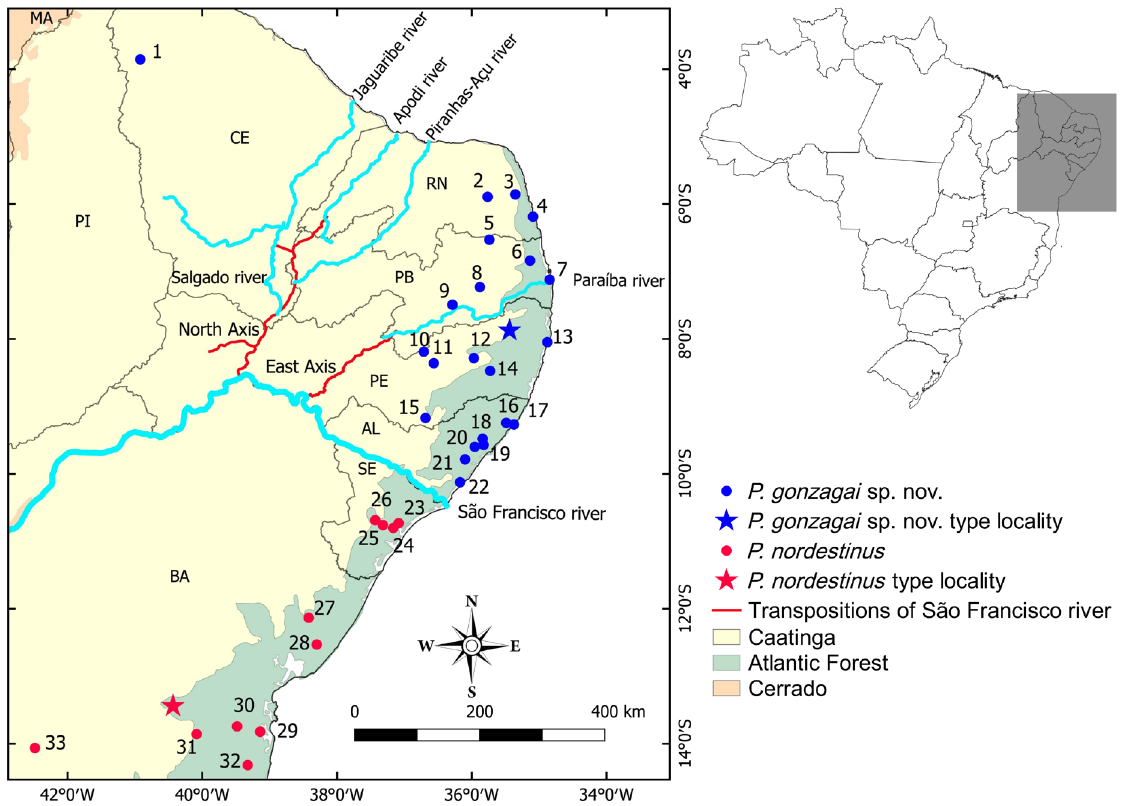
Fig. 1. Map showing molecular, morphological and acoustic samples used in the comparisons between Pithecopus gonzagai sp. nov. (red dots and star) and P. nordestinus (Caramaschi, 2006) (blue dots and star) in north-eastern Brazil. We indicate the original São Francisco River path (blue) and the new path after the installation of the North and East Axes (in red) as a result of the Transposition Project. Municipalities: 1 = Ubajara (CE); 2 = São Paulo do Potengi (RN); 3 = Macaíba (RN); 4 = Tibau do Sul (RN); 5 = Araruna (PB); 6 = Mamanguape (PB); 7 = João Pessoa (PB); 8 = Campina Grande (PB); 9 = Cabaceiras (PB); 10 = Poção (PE); 11 = Sanharó (PE); 12 = Caruaru (PE); 13 = Recife (PE); 14 = Bonito (PE); 15 = Bom Conselho (PE); 16 = Passos do Camaragibe (AL); 17 = São Miguel dos Milagres (AL); 18 = Rio Largo (AL); 19 = Satuba (AL); 20 = Pilar (AL); 21 = São Miguel dos Campos (AL); 22 = Coruripe (AL); 23 = Maruim (SE); 24 = Laranjeiras (SE); 25 = Areia Branca (SE); 26 = Itabaiana (SE); 27 = Alagoinhas (BA); 28 = Mata de São João (BA); 29 = Igrapiúna (BA); 30 = Gandu (BA); 31 = Jequié (BA); 32 = Aurelino Leal (BA); 33 = Caetité (BA); red star = type locality of P. gonzagai sp. nov.: Limoeiro (PE); blue star = type locality of P. nordestinus : Maracás (BA). Brazilian states: AL = Alagoas; BA = Bahia; CE = Ceará; PB = Paraíba; PE = Pernambuco; RN = Rio Grande do Norte; SE =